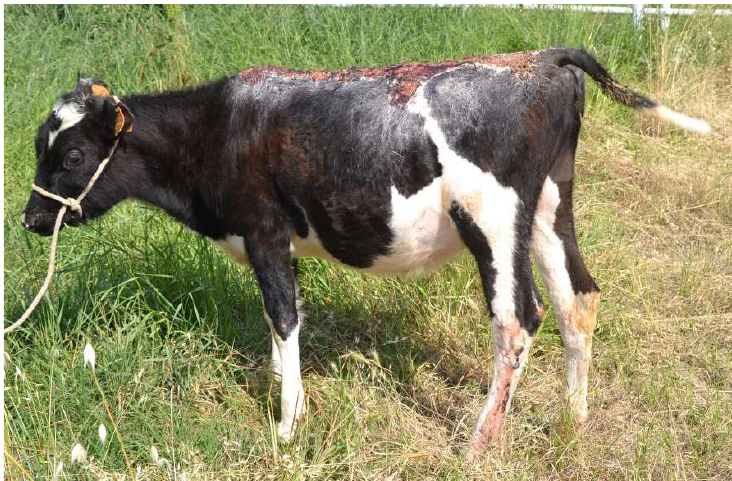
Figure 6. Heifer 2 five months after admission.